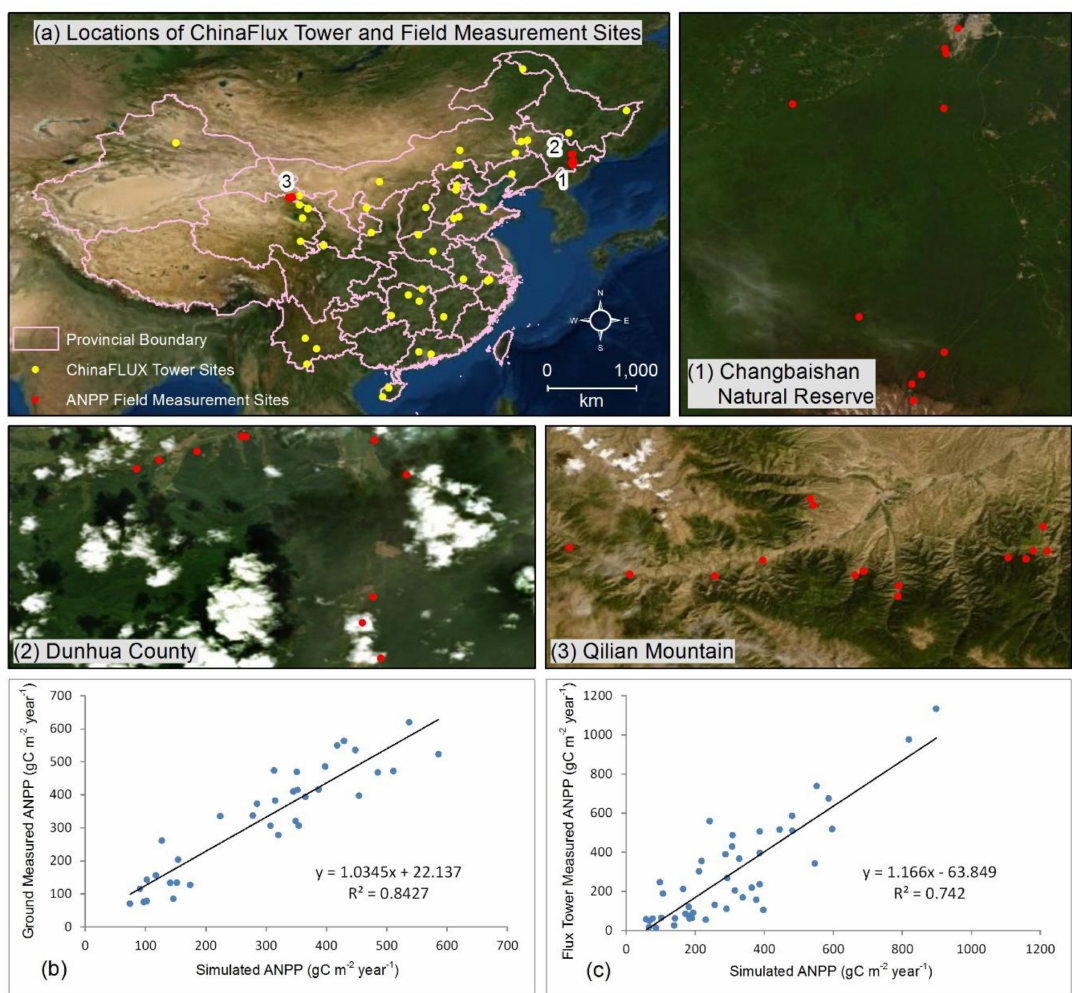
Figure 4. ( a ) The locations of ChinaFLUX tower and field measurement sites. (1–3) The three sample sites selected for field experiments. ( b ) The measurements from the 3 sample sites with the simulated actual net primary productivity (ANPP). ( c ) Comparison of the 45 flux tower measuresments with the simulated